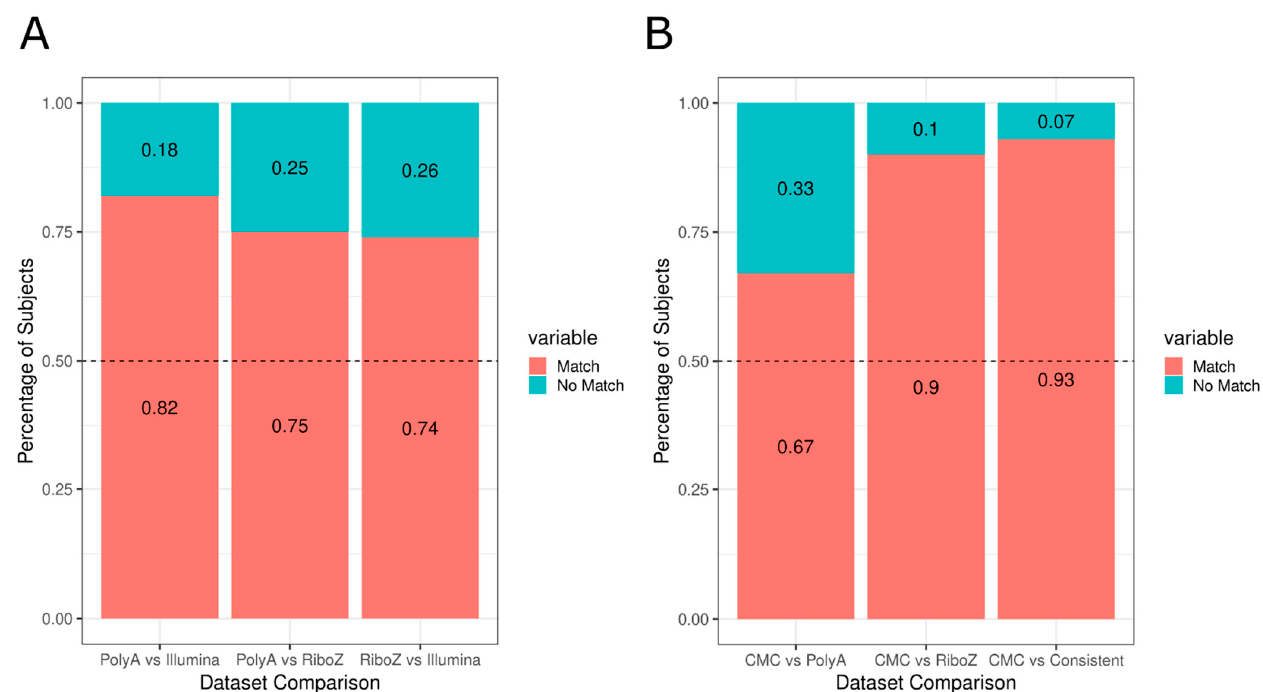
Figure 2. Most subjects are being consistently clustered across four independent datasets. ( A ) Com- parison of polyA, riboZ and Illumina. ( B ) Comparison of polyA, riboZ, and consistently classified subjects from ( A ) with CMC. For each pair of datasets, the percentage of subjects that were clustered as the same type (“match”, pink) versus not the same subtype (“no match”, blue) was calculated. To see more detailed tables, refer to Supplemental Tables S2–S4.